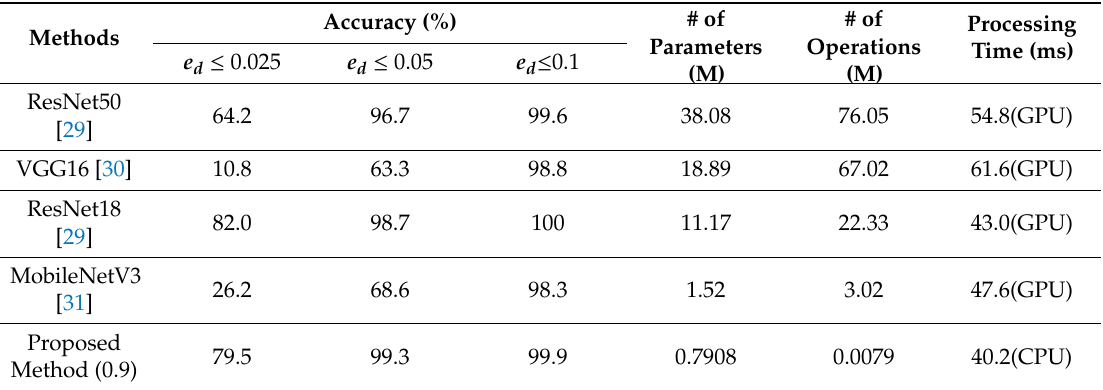
Table 6. Comparison of accuracy, processing time, and numbers of parameters and operations with convolutional neural network (CNN)-based models using GI4E dataset. The proposed method removes 10% of the rules through a rule distillation from the original CCD-RF model.